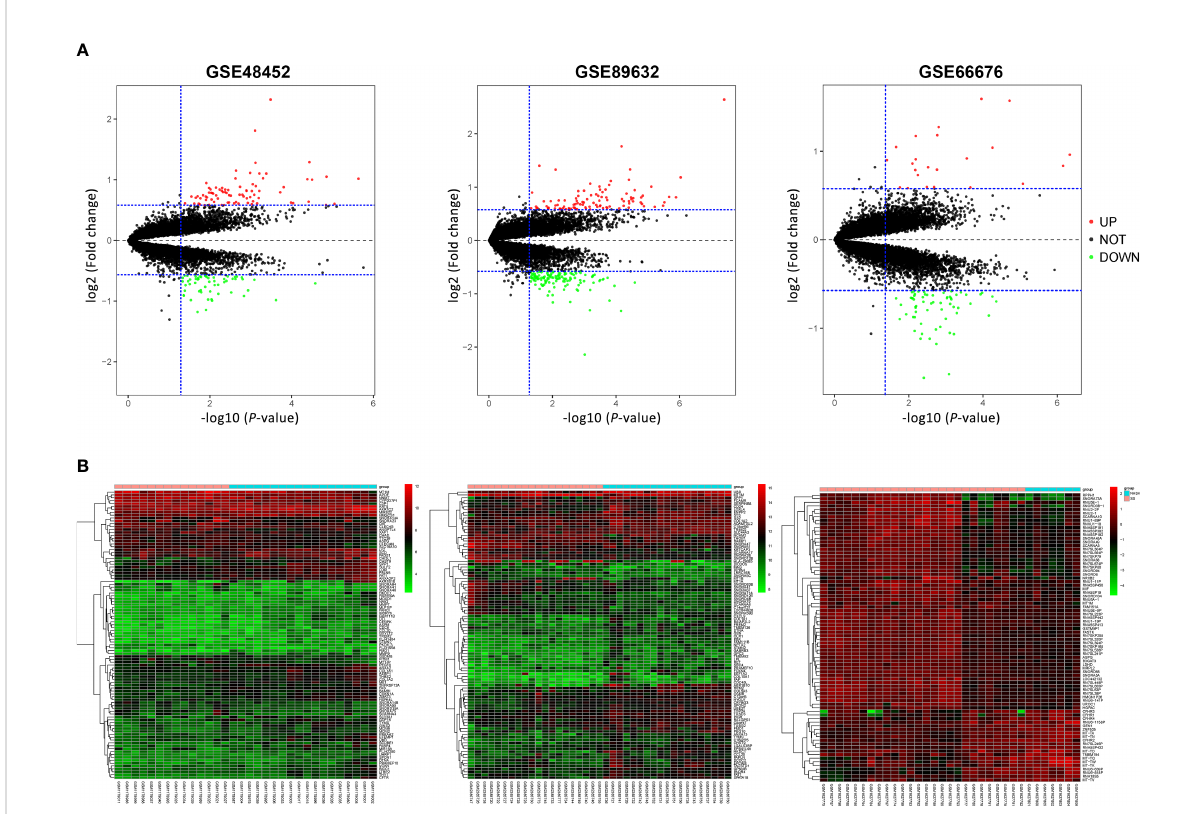
FIGURE 1 Volcano plots and heatmap of three microarray datasets. (A) Volcano plots of GSE48452, GSE89632, and GSE66676. Red points represent upregulated genes, and green points represent downregulated genes. (B) Heatmaps of GSE48452, GSE89632, and GSE66676, and red represents upregulated genes while blue represents downregulated genes in NASH compared with NAFL patients. NAFL, non-alcoholic fatty liver; NASH, non-alcoholic